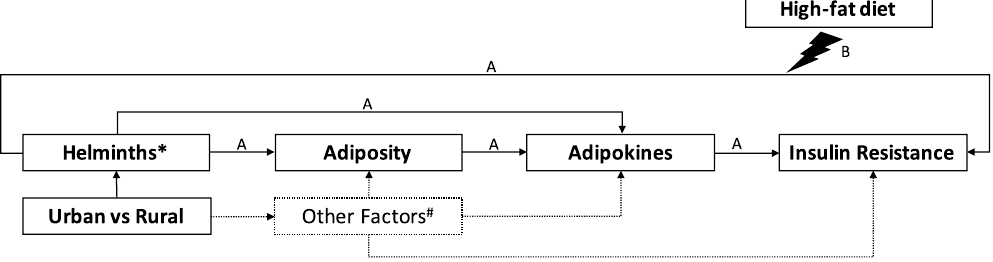
Figure 3. Conceptual framework. In the cross-sectional study ( A ), we assessed whether the differences in past or current exposure to helminths contribute to the difference in insulin resistance (IR) between subjects living in urban and rural area, and whether the observed difference in IR is independent from adiposity. In the high- fat diet (HFD) study ( B ), first, we assessed whether past or current exposure to helminths protect against the HFD-associated increase in IR, independent of adiposity. Next, we also assessed whether the presence of current helminth infection protect against the HFD-associated increase in IR. * Past and current exposure to helminths was assessed by measuring serum total IgE level, a general marker for Th2 responses, commonly induced by soil-transmitted helminth (STH). ** Current exposure to helminths was assessed using stool PCR. # Other factors that were not specifically assessed in this